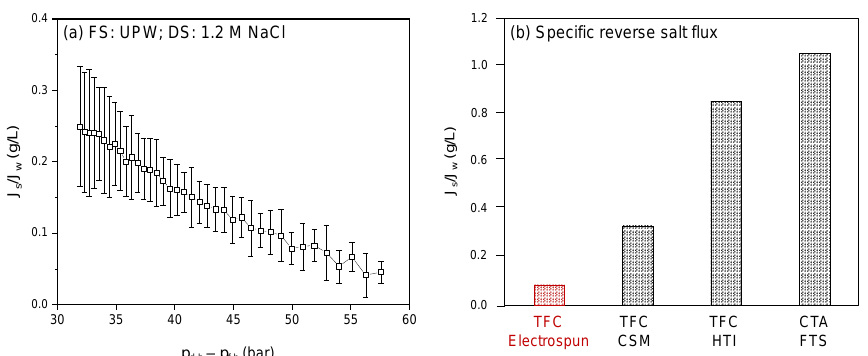
Figure 7. Membrane performance using a 1.2 M NaCl solution DS and UPW as FS. ( a ) Specific reverse salt flux as a function of the osmotic pressure difference over the membrane between bulk DS and bulk FS. Average values calculated based on five separate runs. ( b ) Specific reverse salt flux of the electrospun membrane developed in this work compared to other frequently applied FO membranes CSM [18,31], HTI [32] and FTS [33]. All data measured with demineralized water against 1M NaCl as DS.